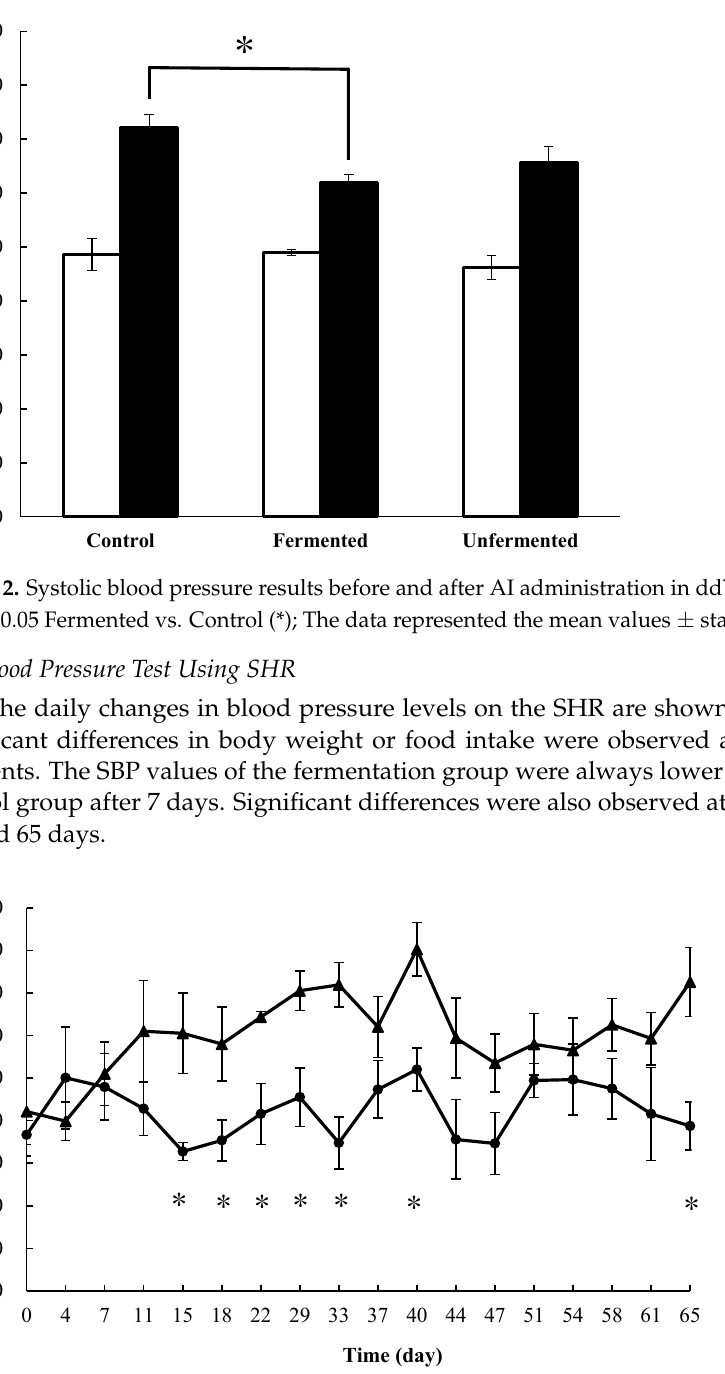
Figure 1. Viable cell counts ( ● ) and pH ( ■ ) of L. pentosus SN001 fermented S. horneri ( A ), ACE inhi- bition activity (final concentration: 0.83 mg/mL) ( B ) The data represented the mean values ± stand- ard error ( n = 4) .